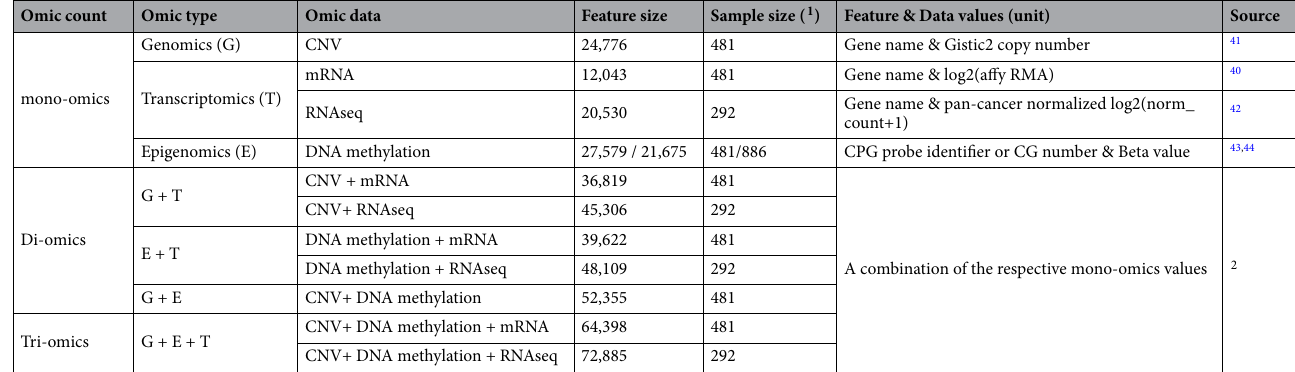
2 Generated through the